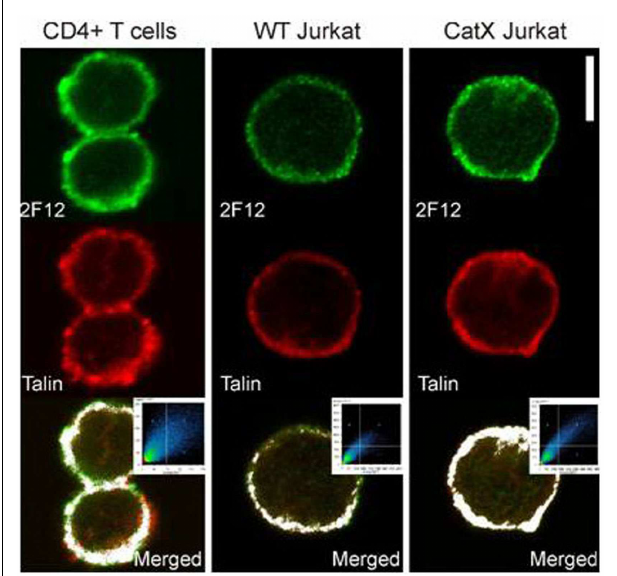
FIGURE 1 | Colocalization of cathepsin X and adaptor protein talin-1 inT cells (120) . Primary CD4 + T cells, Jurkat cells, and cathepsin X-overexpressing Jurkat cells were allowed to migrate on ICAM-1- precoated slides for 30min, and analyzed for colocalization of talin and cathepsin X. Specific antibodies for talin-1 (red) and cathepsin X (2F12, green) have been applied.The threshold level for this display corresponds to one-third of the maximal brightness level. Colocalization is represented by the pixels above the threshold in both channels on the contour plot and on the merged image (white color). Original scale bar, 5 µ